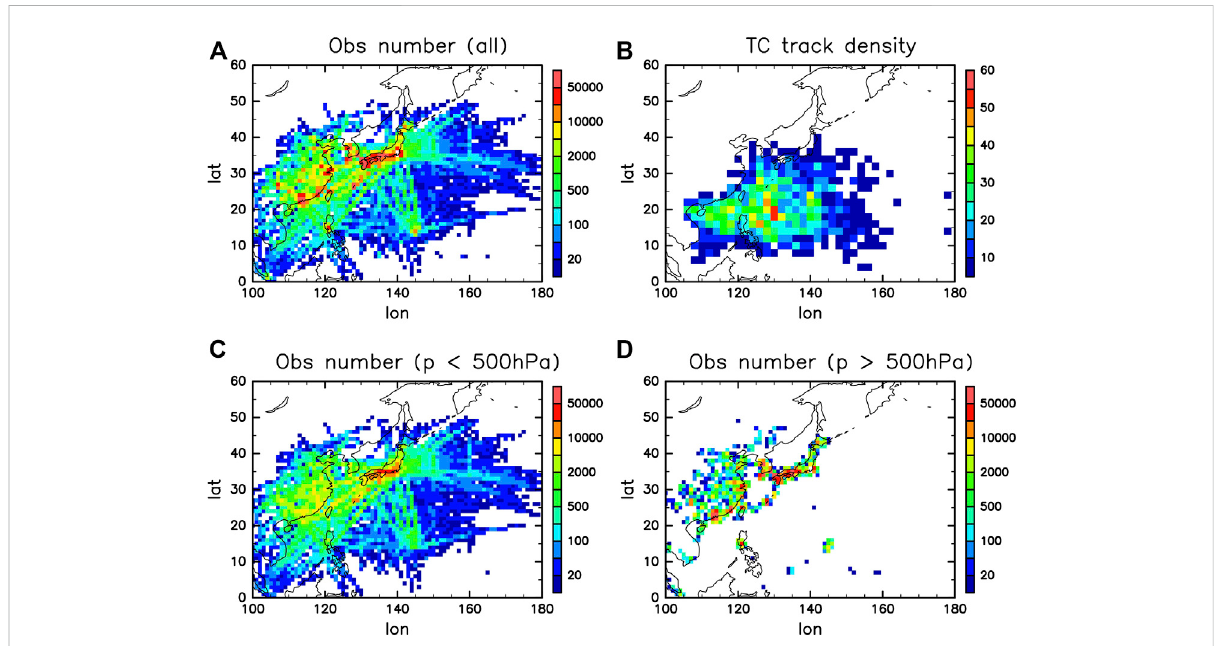
FIGURE. 1 (A) The number of the ACARS/AMDAR temperature observations within r < 1,200 km during 2010 – 2020 used in this study. (B) TC track density obtained from 6-hourlybest track data during 2010 – 2020. The number of ACARS/AMDAR observationsis divided into those (C) above 500 hPa and (D) below 500